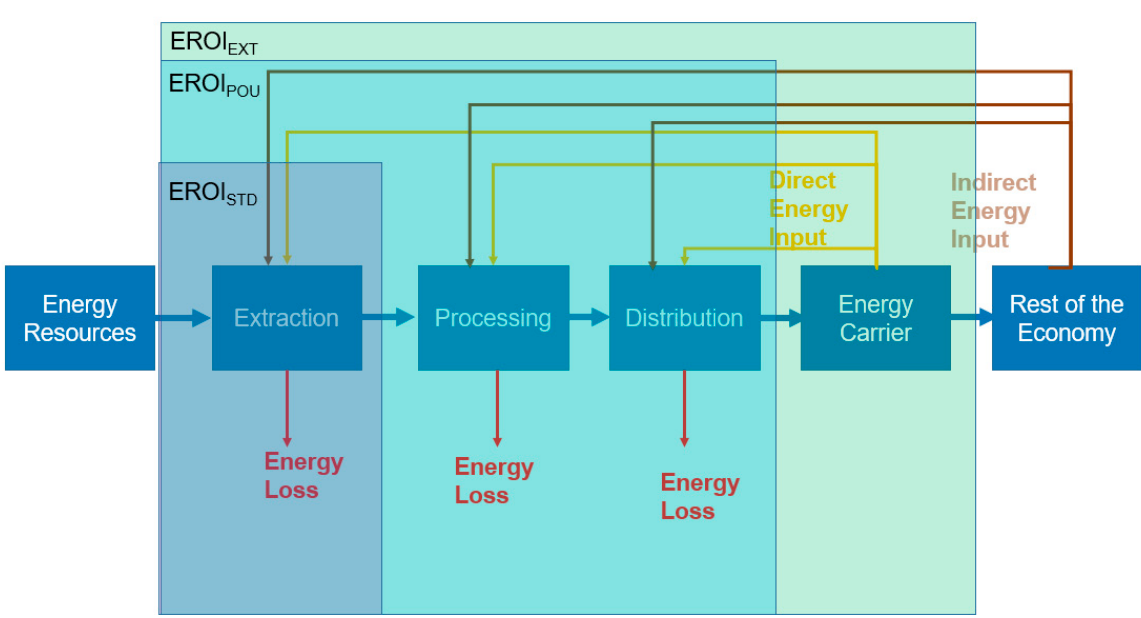
Figure 5. Possible boundaries of a net energy assessment, adapted from Hall et al. [23].